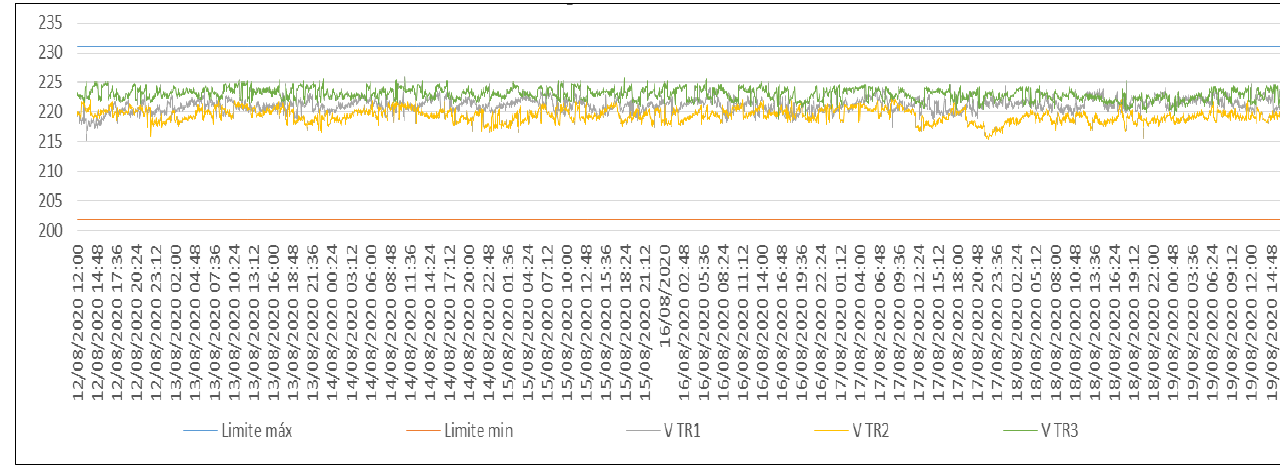
Figure 2: Supply voltage indicator graphic.